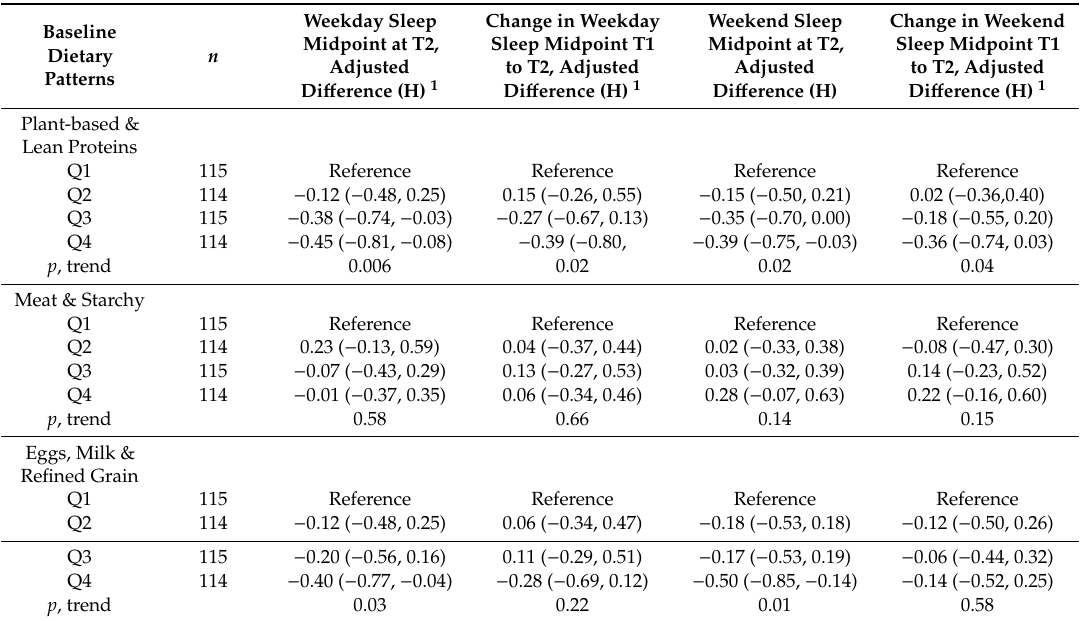
Table 4. Multivariable associations between baseline dietary patterns and prospective sleep midpoint. Baseline